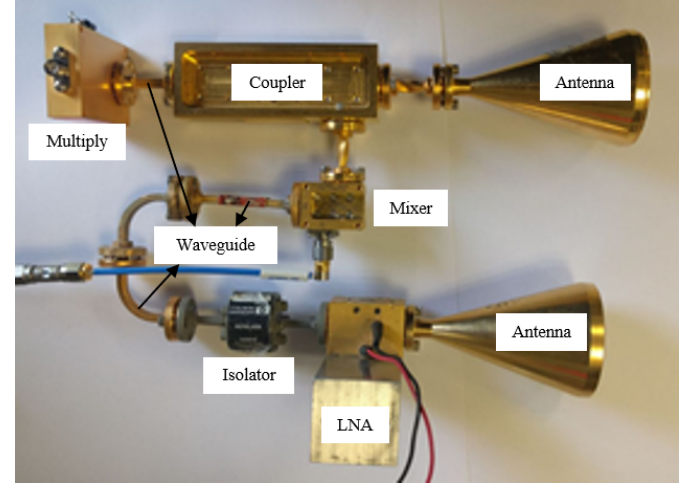
Figure 4. The CW micro-Doppler